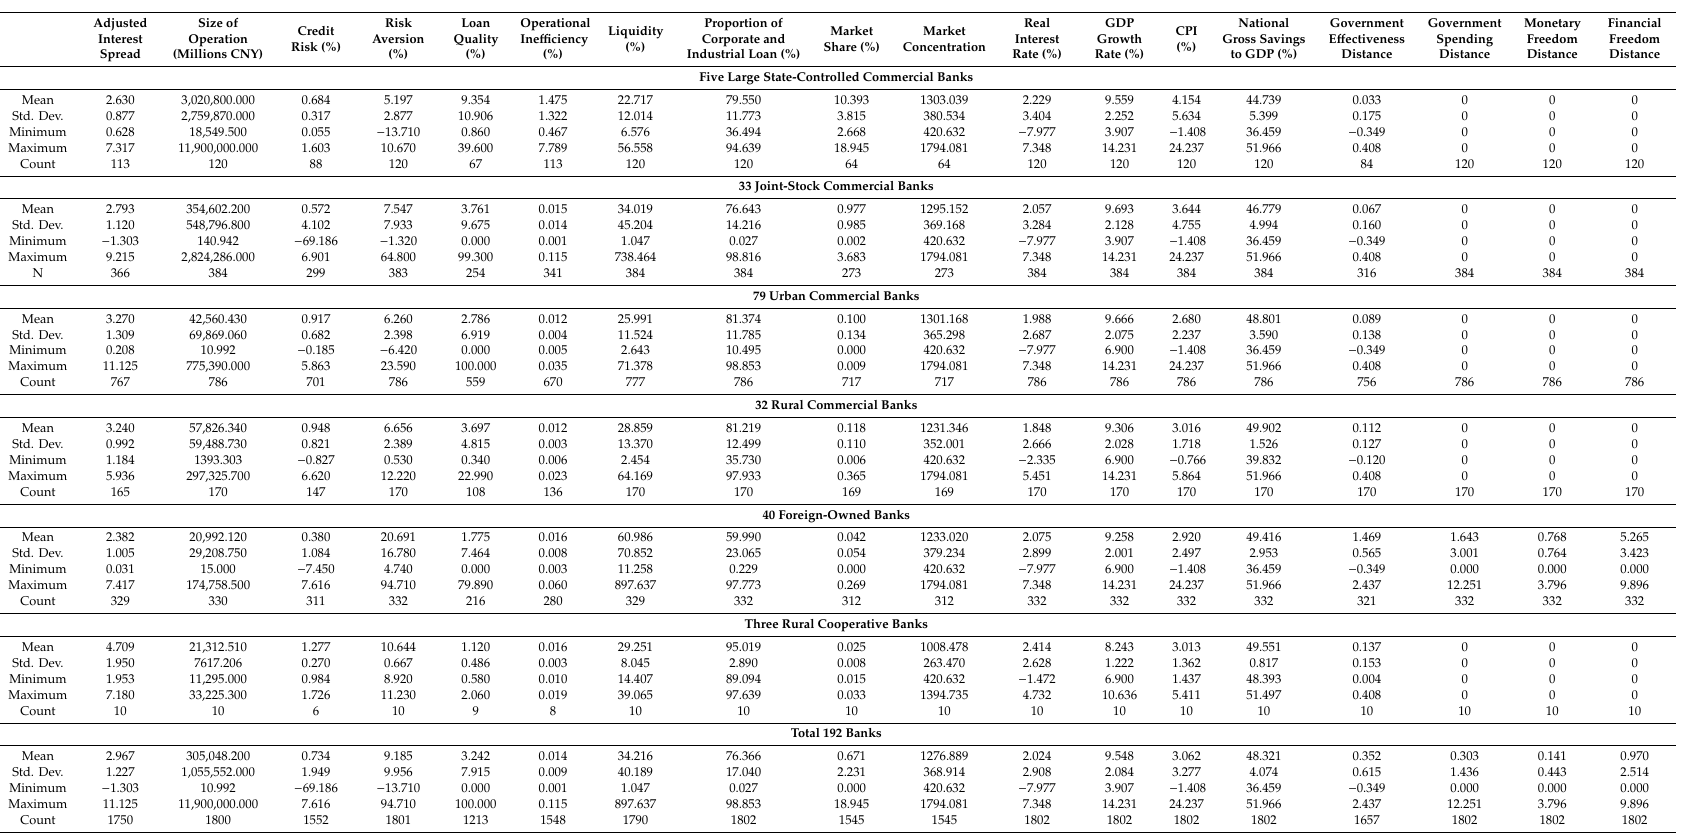
Table 2. Summary